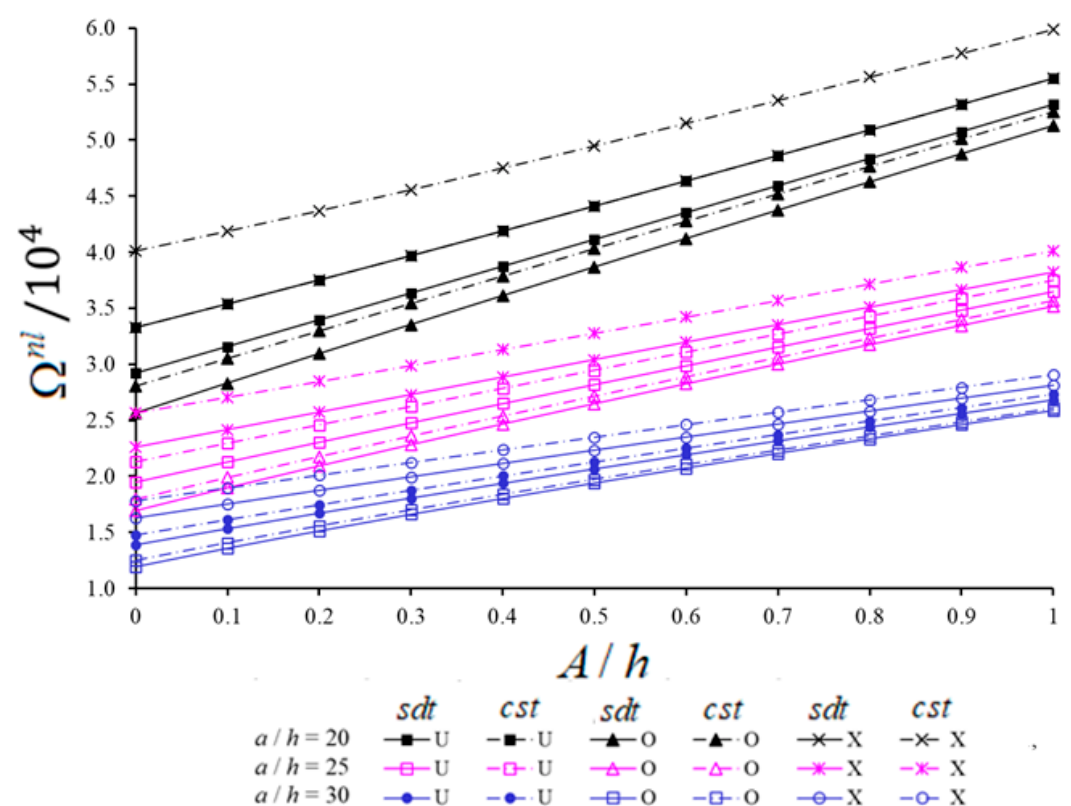
Figure 7. Variation of NLFVs of spherical shells with U, V, O and X patterns within CST and SDT against the / A h for different / a h .